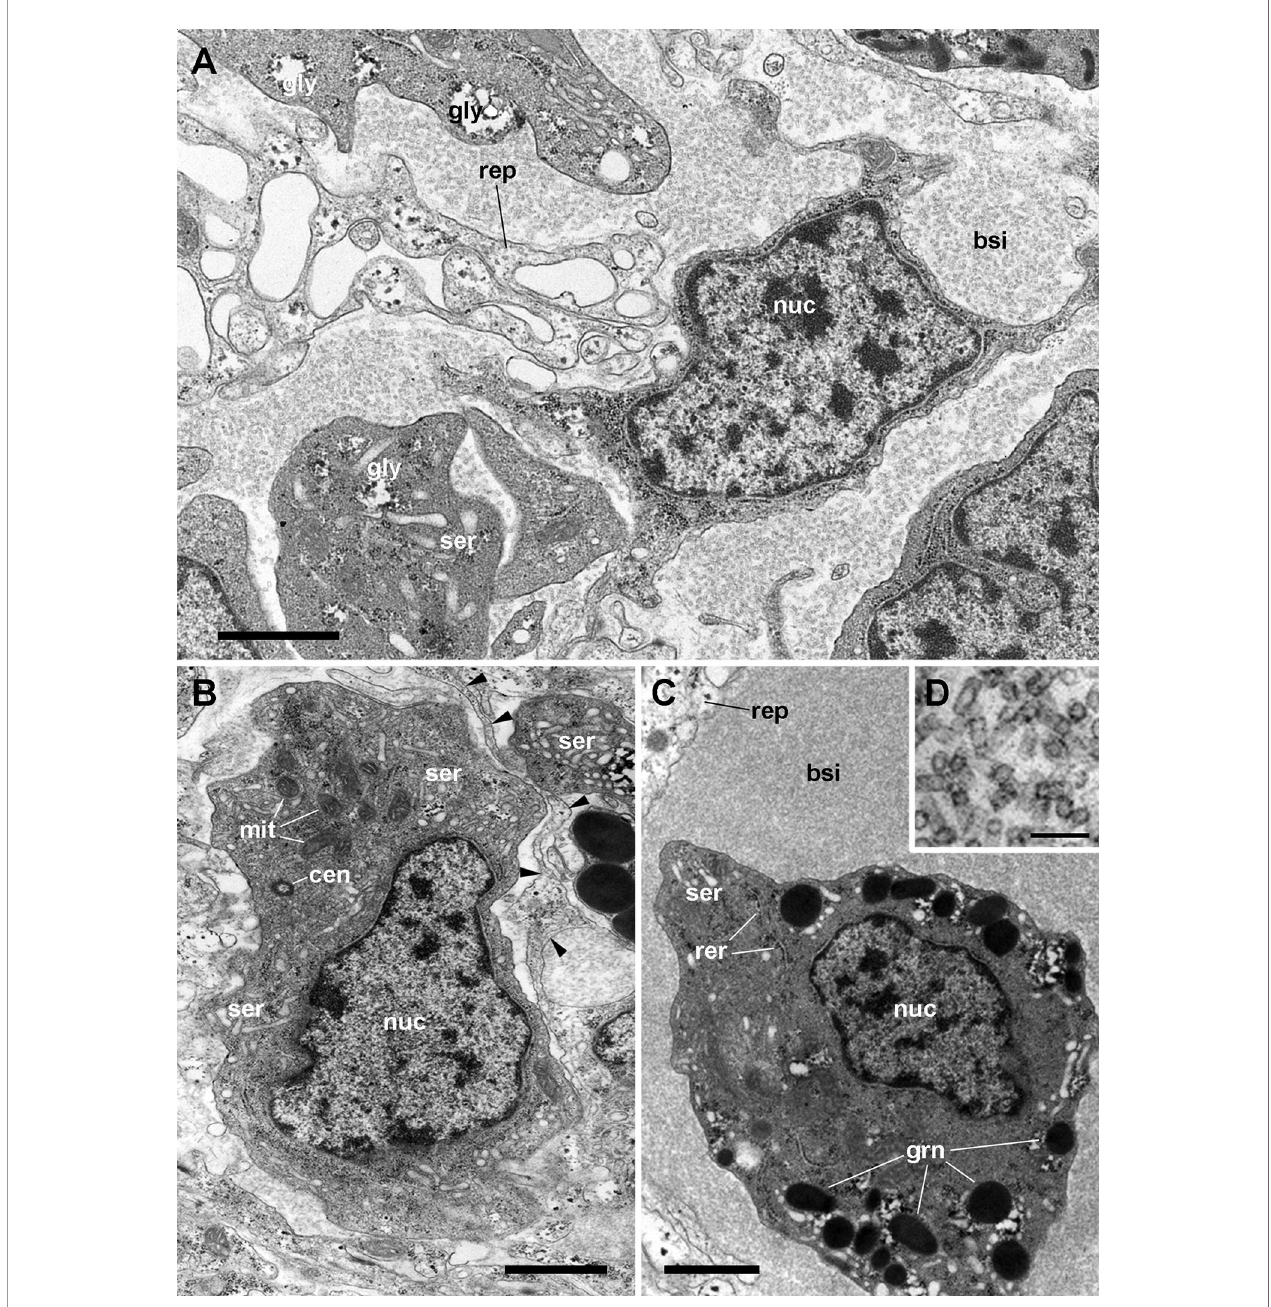
FIGURE 11 | Renal blood sinuses, hemocytes, and hemocyanin polymers under TEM. (A) Blood sinus containing hemocyanin polymers and an agranulocyte lying beside a projection of a renal epithelial cell. Parts of other hemocytes and of the epithelial extensions show dark clumps and non-membrane bound areas, which are likely glycogen deposits. (B) A hyalinocyte showing eccentric nucleus, pro fi les of the SER, and numerous mitochondria. Intimate contacts between different hemocytes and thin epithelial projections are seen (arrowheads), but there are no intercellular junctions. (C) A hemocyanin fi lled blood sinus containing a granulocyte with an eccentric nucleus and electron-dense R-granules. (D) Detail of hemocyanin polymers. Scale bars represent: (A – C) 1 µm; (D) 100 nm. BLA, basal lamina; BSI, blood sinus; CEN, centriole; grn, R-granules; MIT, mitochondrion; NUC, cell nucleus; REP, renal epithelium; RER, rough endoplasmic reticulum; SER, smooth endoplasmic reticulum. From